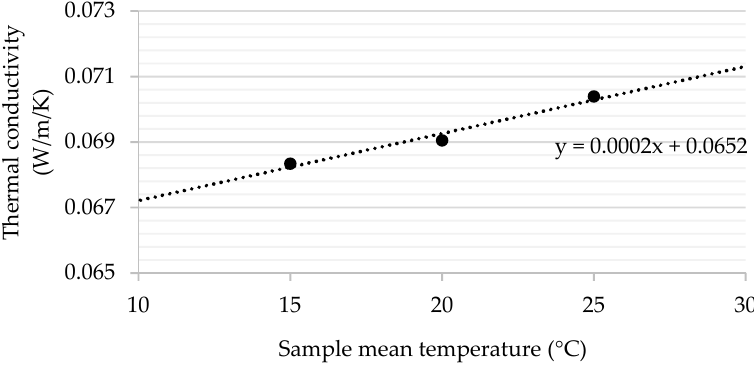
Figure 11. Thermal conductivity of experimental and reference boards at 20 °C [40,41].